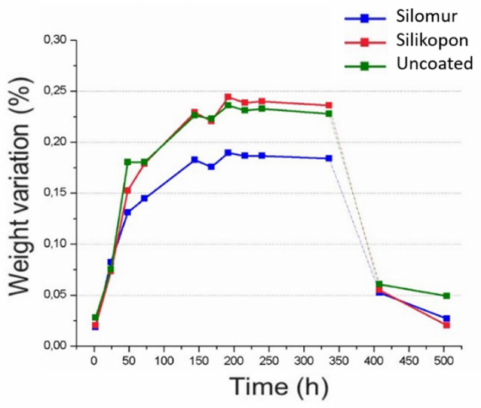
Figure 3. Water uptake according to ASTM D570 specifications.